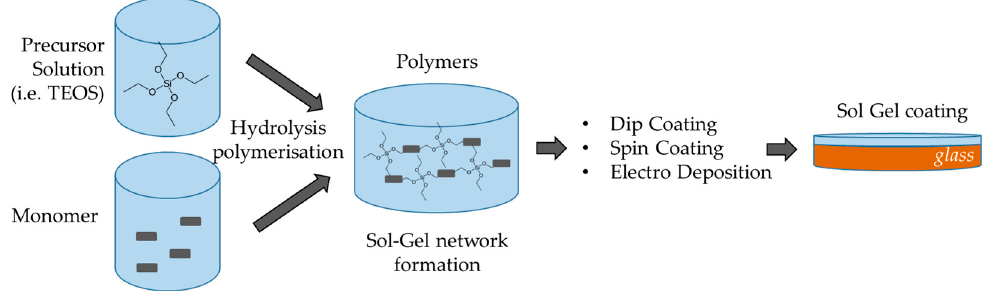
Figure 7. Sol-gel synthesis route.